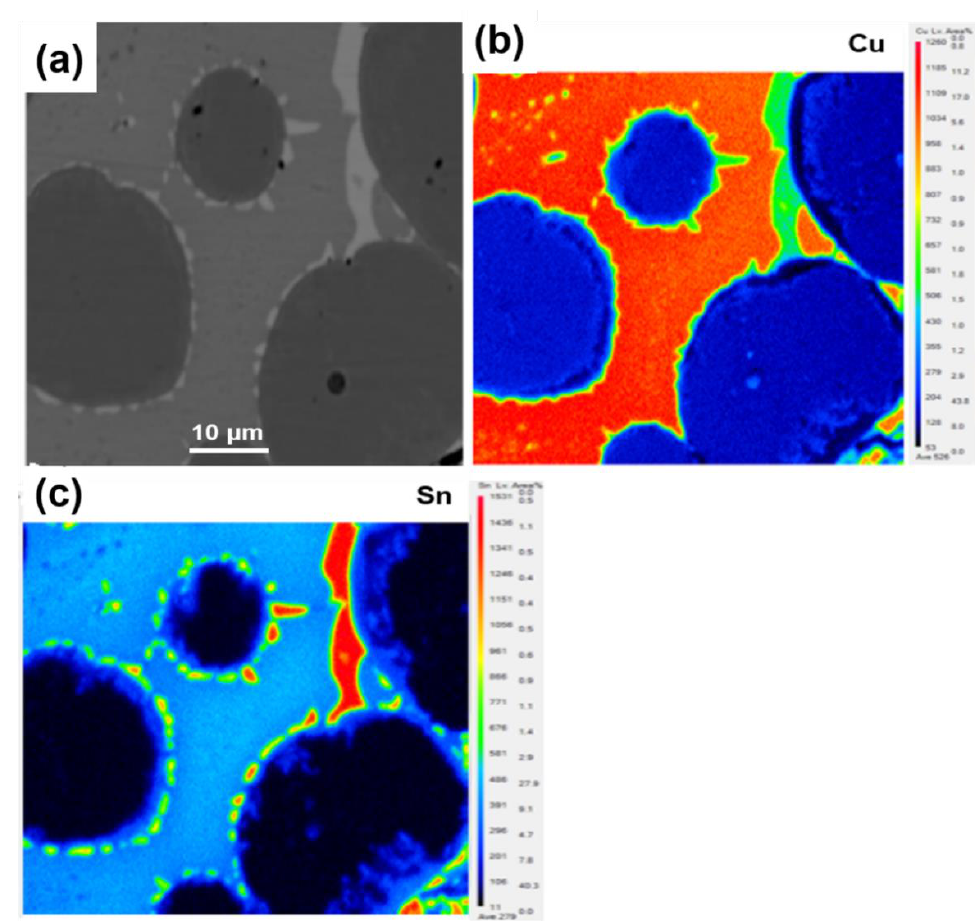
Figure 10. Electron probe microanalysis (EPMA) mapping scan analysis of the sample by microwave sintered at 880 °C: (a) EPMA image, (b) distribution of Cu, (c) distribution of Sn